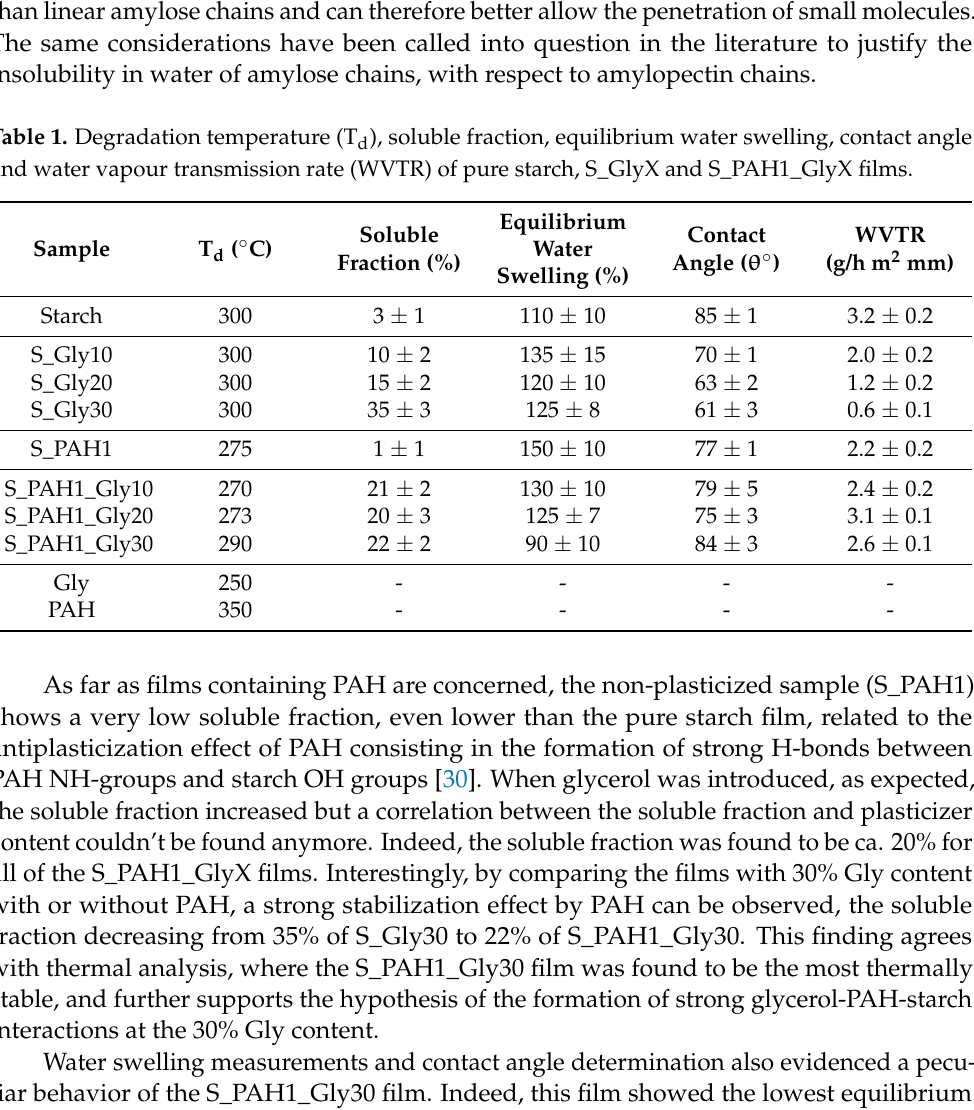
Table 1. Degradation temperature (T d ), soluble fraction, equilibrium water swelling, contact angle and water vapour transmission rate (WVTR) of pure starch, S_GlyX and S_PAH1_GlyX films. Equilibrium Soluble Contact WVTR Sample T d ( ◦ C) Water Fraction (%) Angle ( θ ◦ ) (g/h m 2 mm) Swelling (%) Starch 300 3 ± 1 110 ± 10 85 ± 1 3.2 ± 0.2